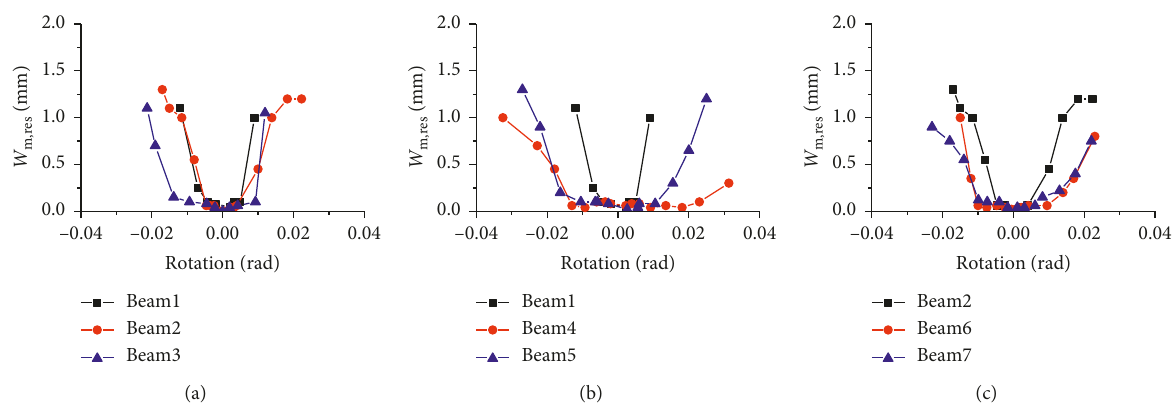
Figure 7: Maximum residual crack width of specimens. (a) Effect of aspect ratio. (b) Effect of flange-web ratio. (c) Effect of steel ratio.